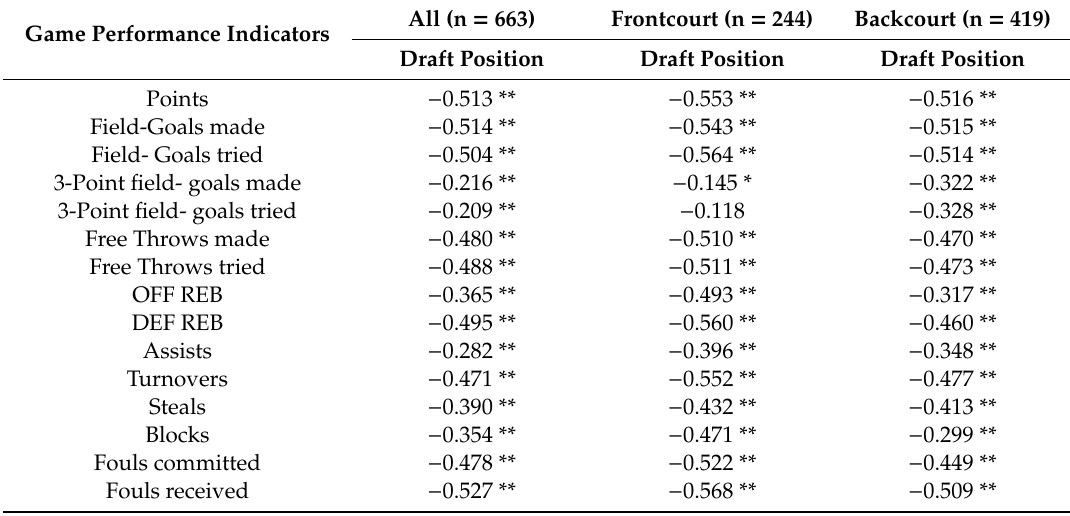
Table 4. Pearson correlation coe ffi cients between draft position and game performance indicators in All, Frontcourt and Backcourt